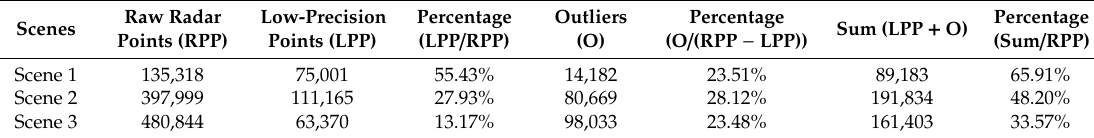
Figure 16. Data volume of the system. The number of point clouds in the original data of the three scenes is compared, the number of point clouds after filtering out low-precision points, and the number of point clouds after filtering out low-precision points and outliers. Table 2. Statistics of the screening rate of low-precision points and